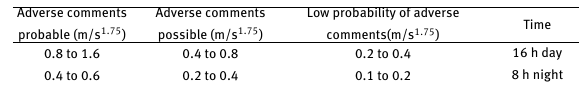
Table 3: Annoyance level in respect of equivalent VDV in residential buildings [43]. Adversecomments Adversecomments probable(m/s 1.75 ) possible(m/s 1.75